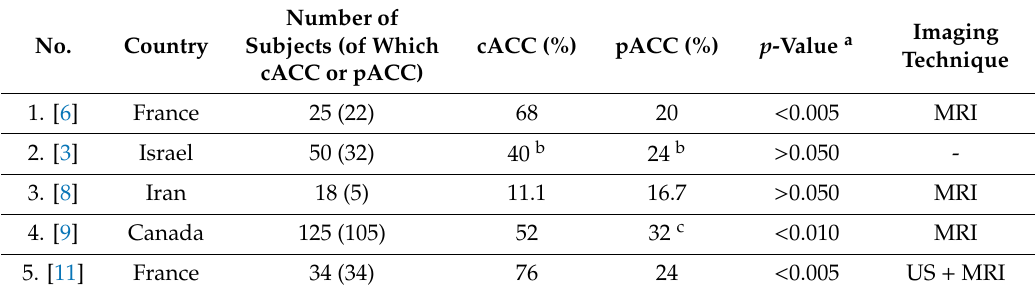
Table 1. Comparison of the occurrence of complete and partial corpus callosum agenesis (ACC) in five